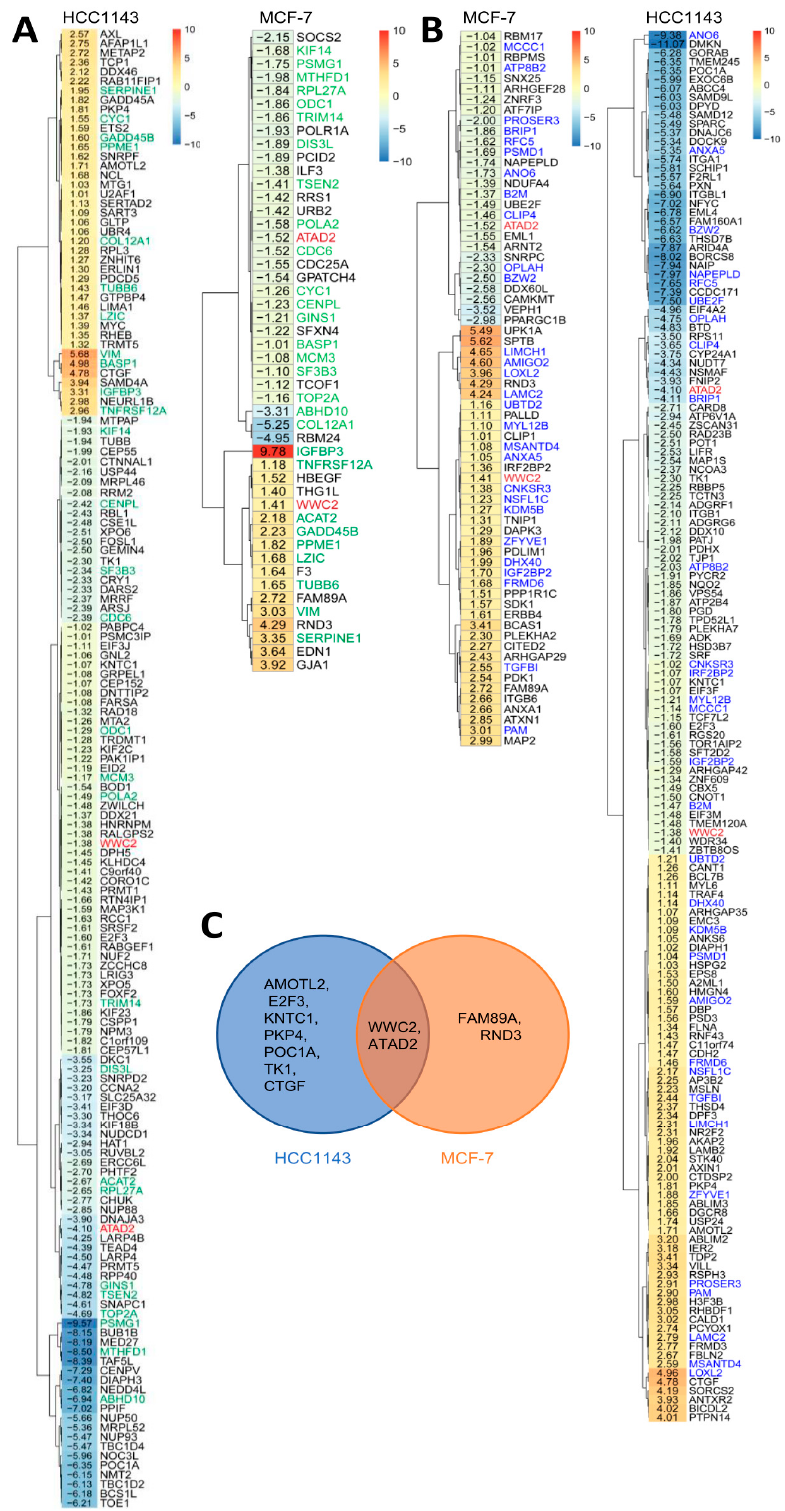
Figure 3. Identification of candidate YAP/TAZ/TEAD target genes in hypoxia-responsive genes in MCF7 and HCC1143 cells. ( A , B ) Heatmaps showing intersection of TempO-Seq data for hypoxia- regulated genes in MCF7 and HCC1143 cells with YAP/TAZ/TEAD target genes reported in literature ( A ; [36,37]) and candidate TEAD1-4-binding genes identified using DoRothEA ( B ; [38]). Values are Log 2 fold change under hypoxia relative to normoxia. Genes labeled green in ( A ) or